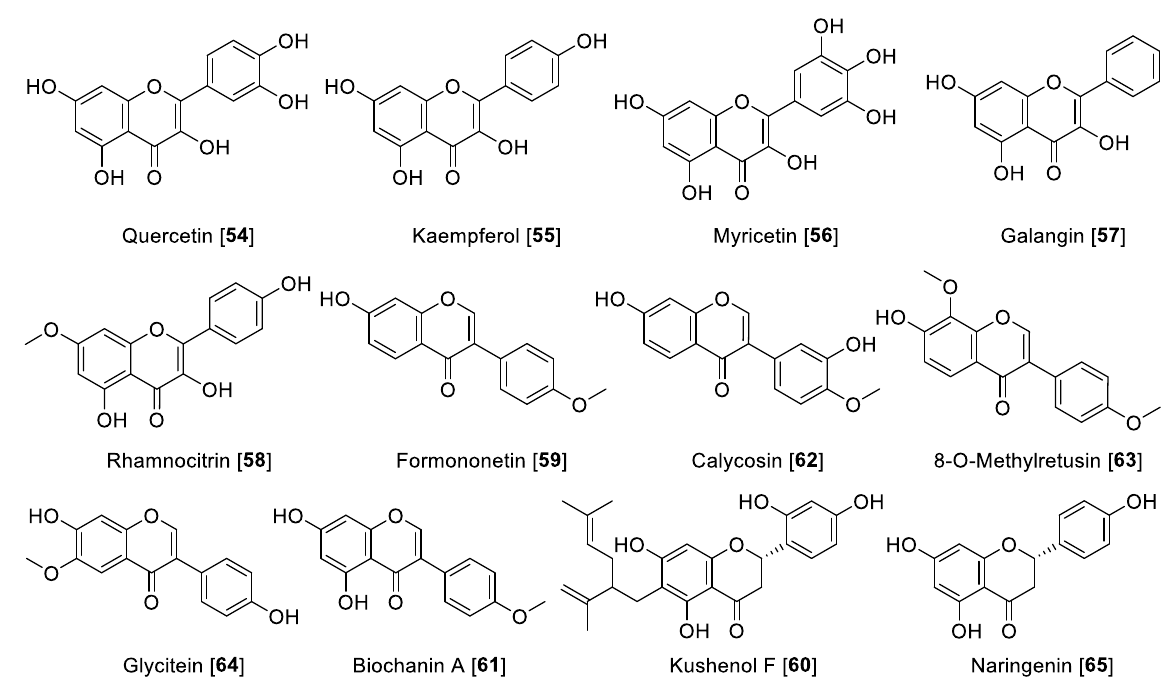
Figure 7. Chemical structure of selected flavanol, isoflavone, and flavanone MAO inhibitors.